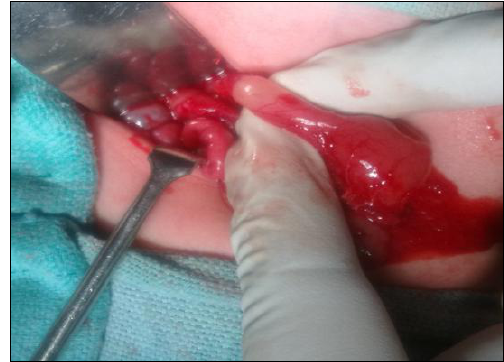
Figure 1: Operative photograph showing type- 3 CPA.